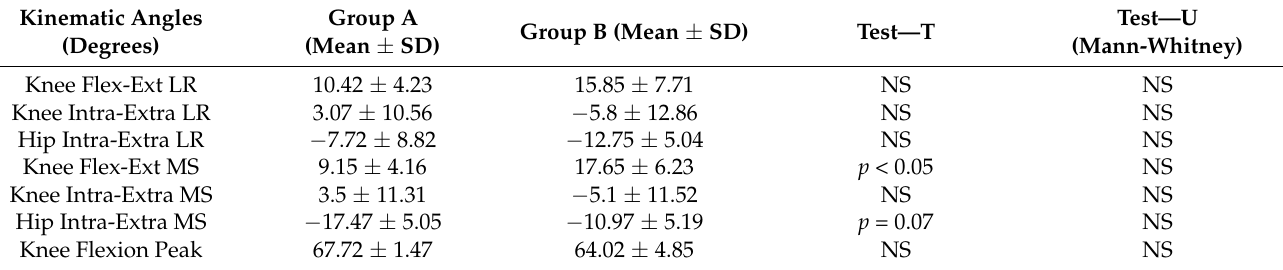
Table 6. Most significant kinematic parameters for both study groups. We report a weak significance in knee flexion during the intermediate stance phase (MS), which is greater in Group B patients (no VERASENSE), and a certain trend ( p < 0.15 on the T-test) in extra-rotation of the hip, which is greater in patients of the Group A (VERASENSE) during the intermediate support phase. LR: Load-Response; MS: